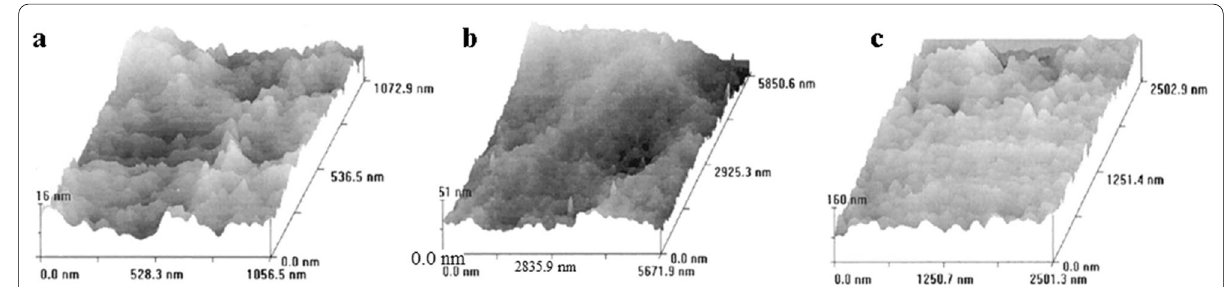
Fig. 34 Surface roughness of Si{100} etched in 4.5 M KOH complexant; c simple 4.5 M KOH [52], © 1999,